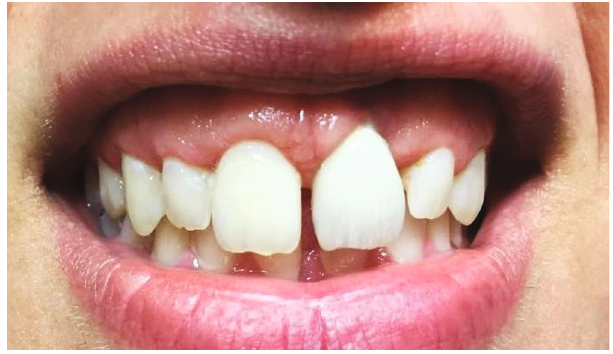
Figure 6: Day 21 examination.